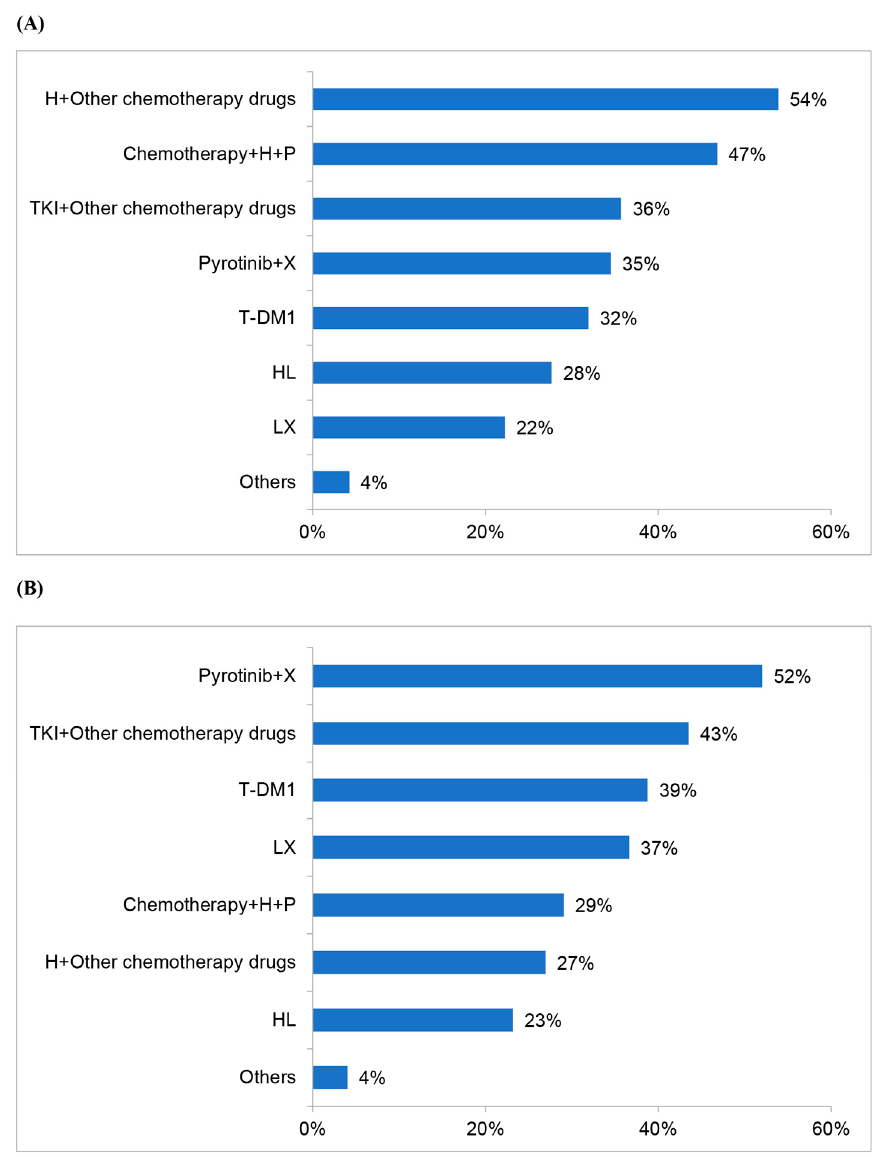
Figure 5. The second-line treatment regimens chosen by 423 doctors for HER2-positive MBC patients: ( A ) PFS in the first-line setting ≥ 6 months; and ( B ) PFS in the first-line setting < 6 months.